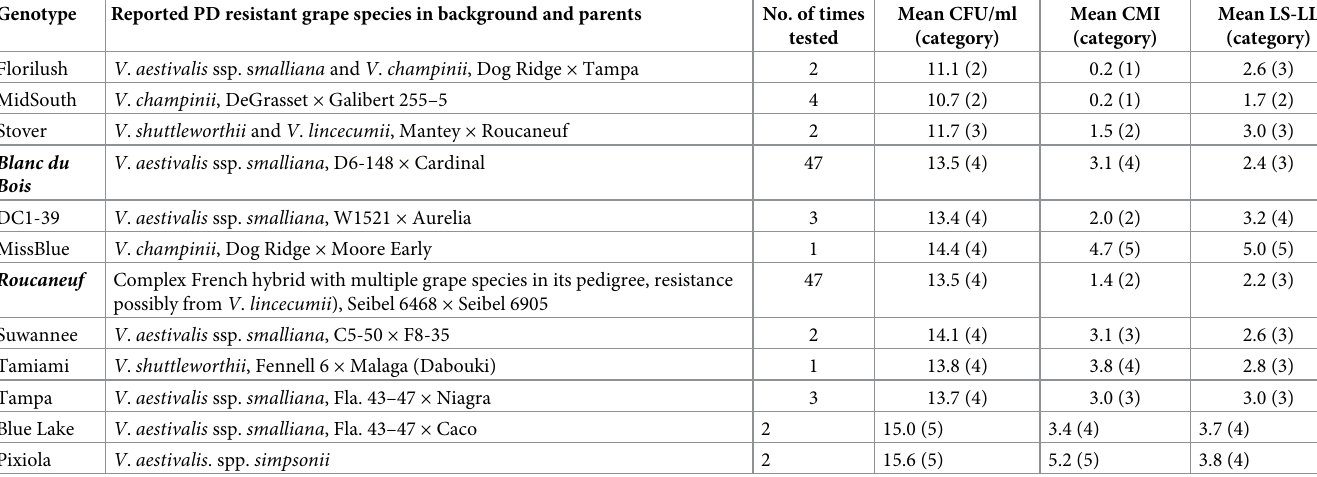
Table 3. List of 12 southeastern US varieties (with the exception of Roucaneuf) reported to be Pierce’s disease (PD) resistant based on the survival rate and visual symptoms of leaf scorch under natural disease pressure in the field. The two italicized and bolded accessions are reference plants, included in every greenhouse screen- ing experiment. The other ten accessions were tested in earlier years of the PD resistance breeding program under greenhouse conditions and bacterial populations were quantified by ELISA. Cane maturation index (CMI) and leaf scorch/leaf loss symptoms were also recorded.